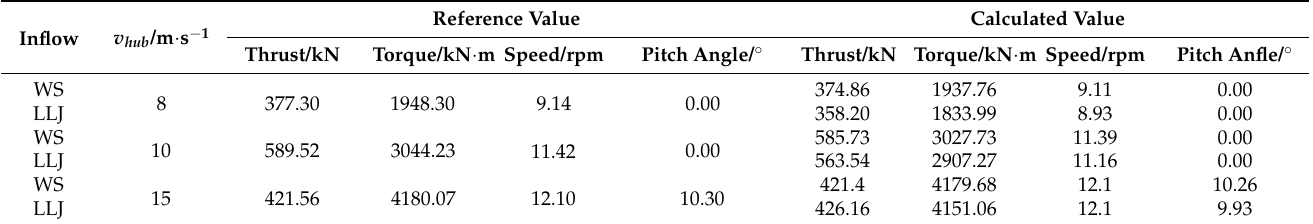
Table 7. The rotor speed, blade-pitch angle, and aerodynamic loads under different working conditions.